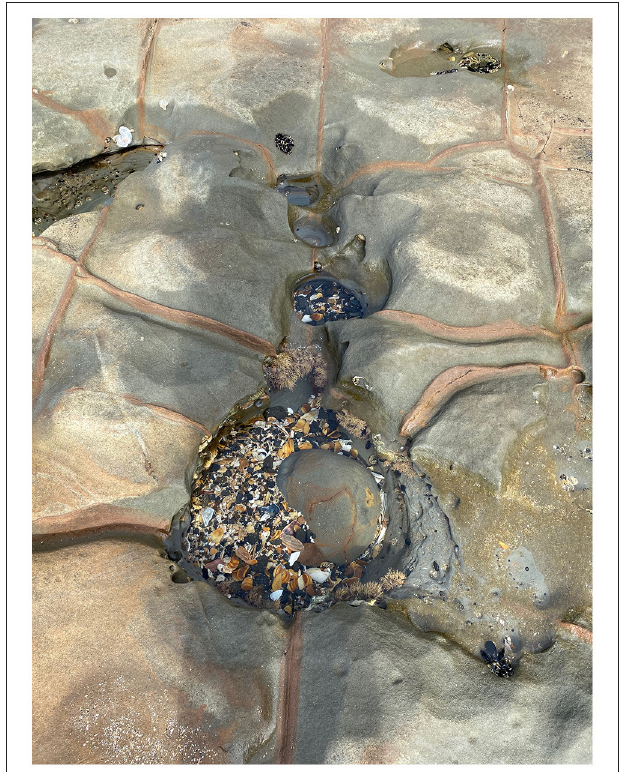
FIGURE 2 | Shadow Tide Pool Trio. Waitemat ¯ a Harbour, Takapuna Beach, Aotearoa New Zealand, September 2021. Photo credit, Jennifer